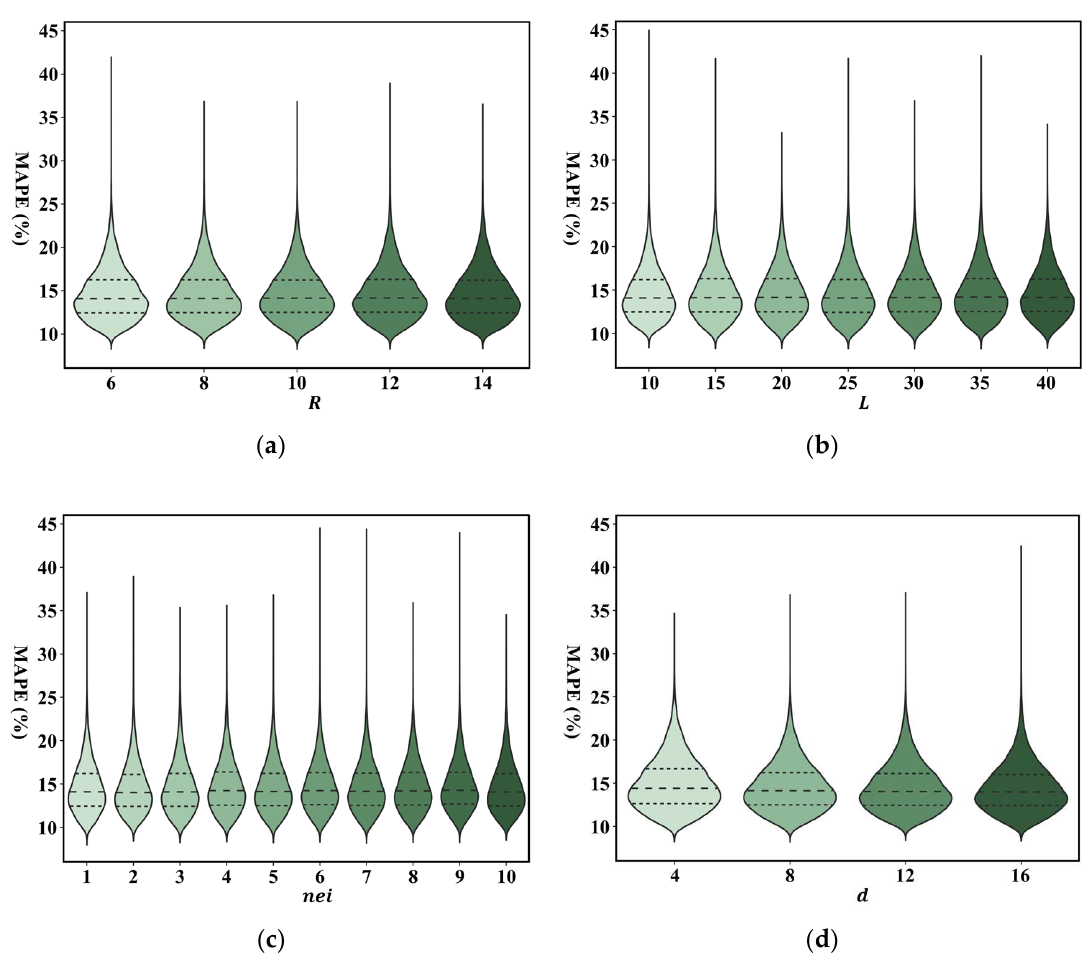
Figure 10. ETA performance for the different hyperparameter settings, including: ( a ) R : the number of sequences generated from each starting node; ( b ) L : the length of the sequence generated by the random walk; ( c ) nei : the size of neighborhood in representation learning; ( d ) d : the dimension of the learned representation.